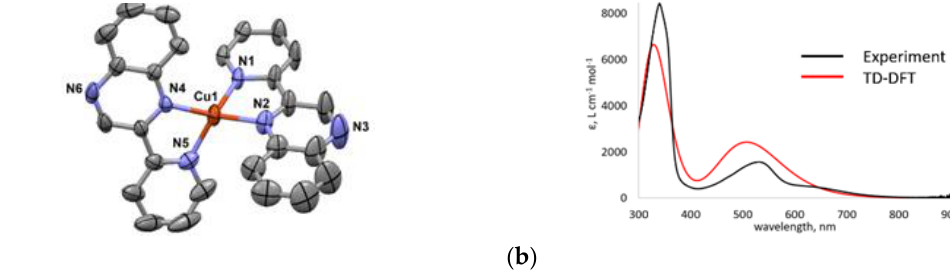
Figure 1. ( a ) ORTEP of [1] BF 4 . Thermal ellipsoids are drawn from 50% probability ( [1] + ) ( b ) Experimental and calculated absorption spectra of [1] + in DMF solvent.